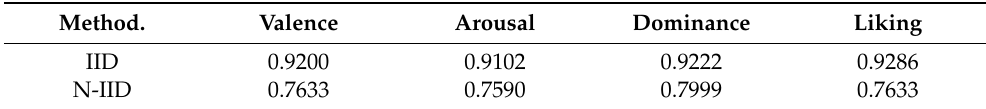
Figure 6. Federal learning of rising accuracy curves in the face of IID and N-IID data distributions, trained and validated in four labels of the DEAP dataset. Table 4. The accuracy of the models obtained by training on DEAP datasets with IID and N-IID distributions, respectively.